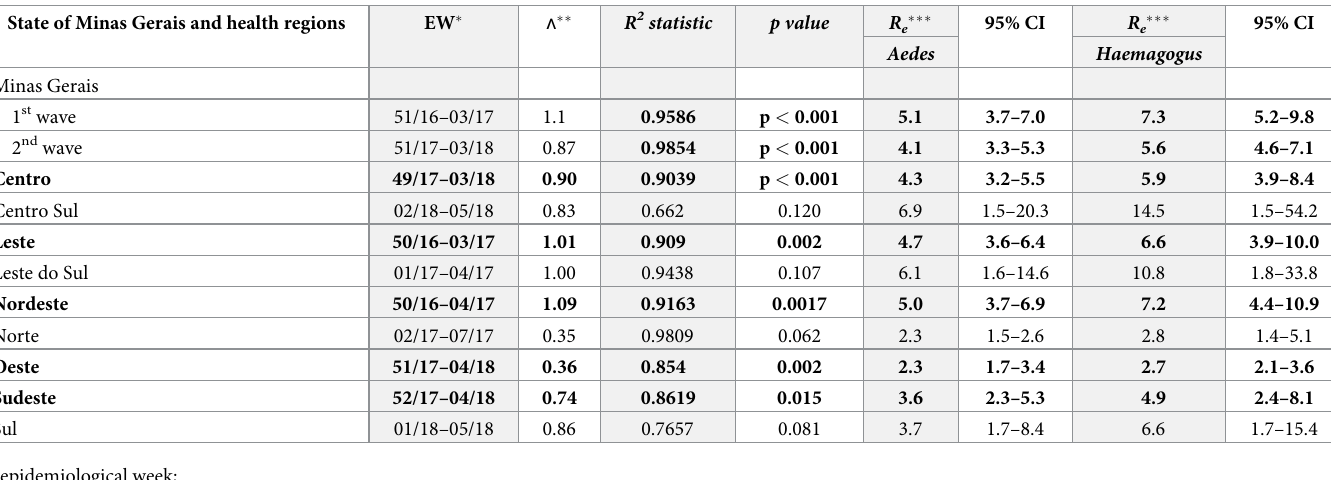
Table 3. Effective reproduction number and strength of infection according to major health region and epidemiological week, Minas Gerais, Brazil, 2016 to 2018. Three- to seven-week periods were selected with increases in cases, normally identified at the start of the outbreak in each of the macroregions. The macroregions in the bold face presented statistically significant values (p value < 0.05) in the regression that estimated the rate of growth of cases. The macroregions Norte, Jequitinhonha, Tri- aˆngulo do Norte, and Triaˆngulo do Sul did not display upward curves, thus preventing calculation of the reproduction number in these